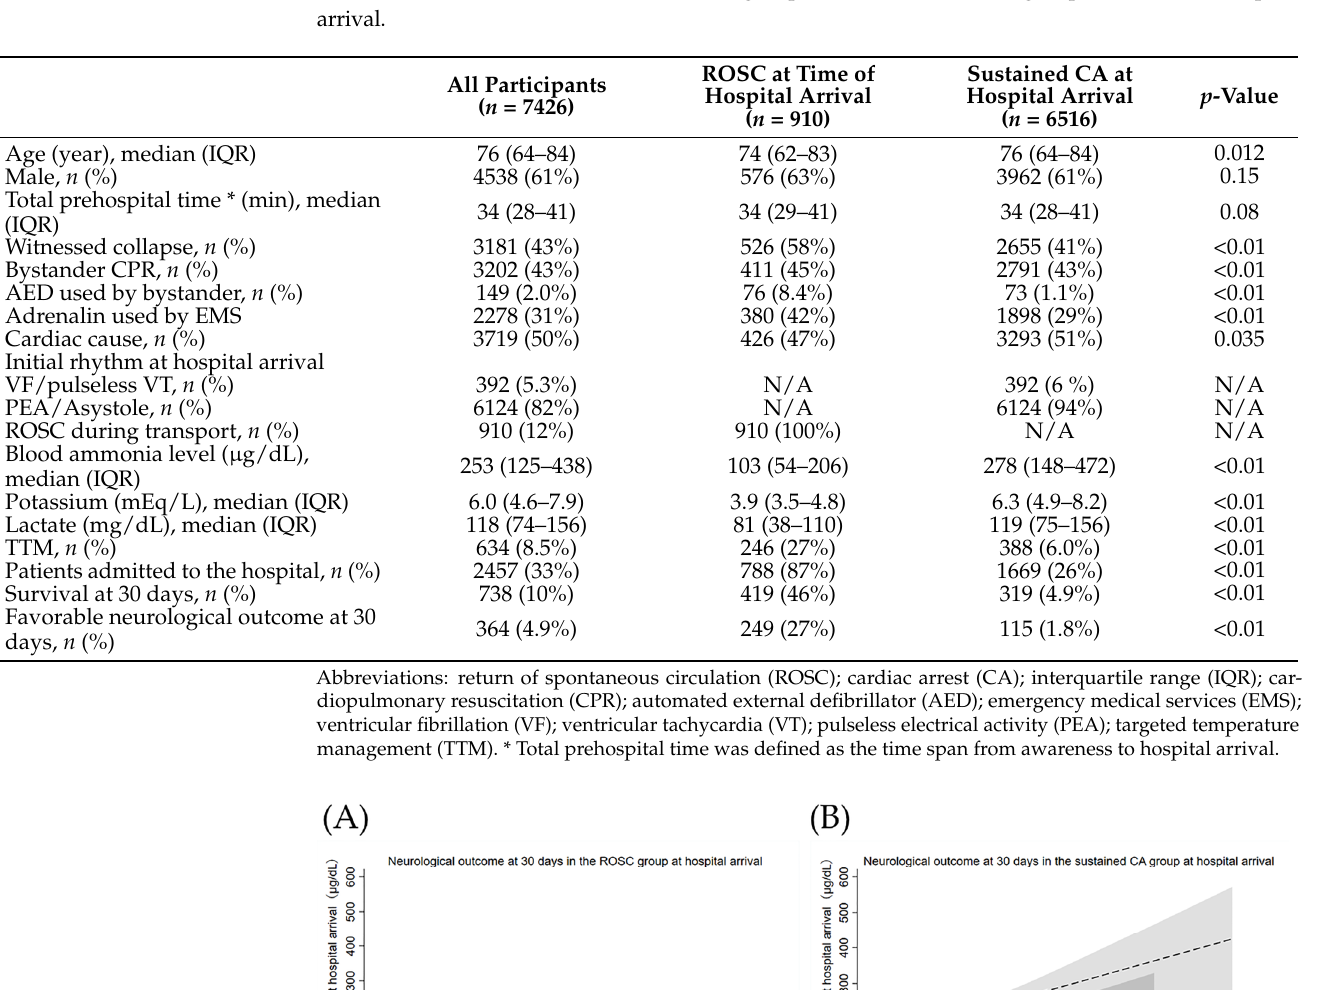
Table 3. Patient characteristics in the ROSC group and the sustained CA group at the time of hos- pital arrival.